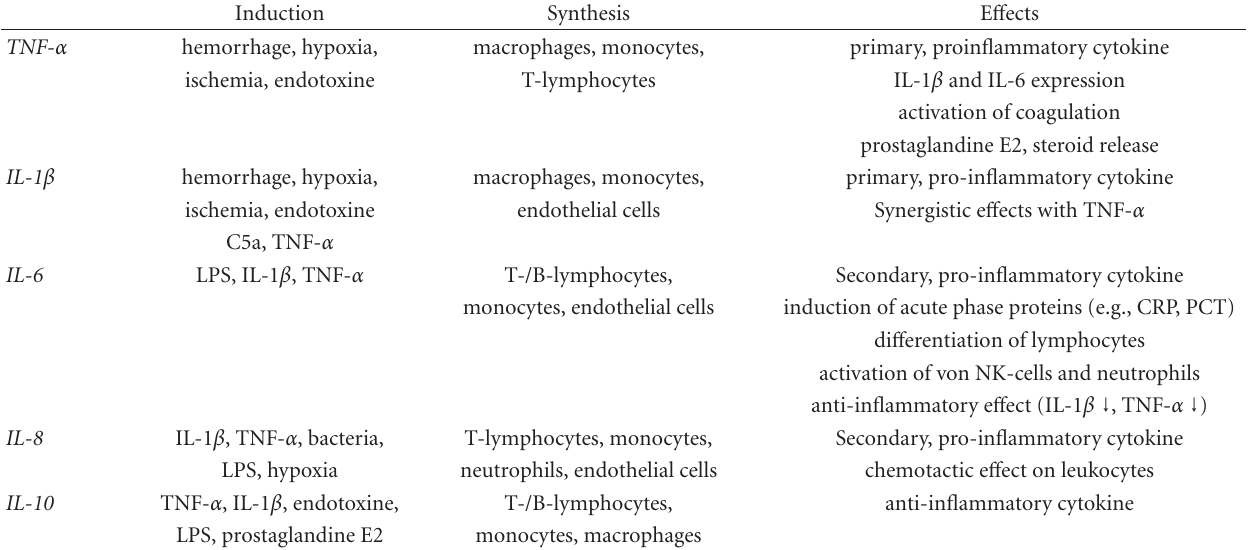
Table 2: Inflammatory